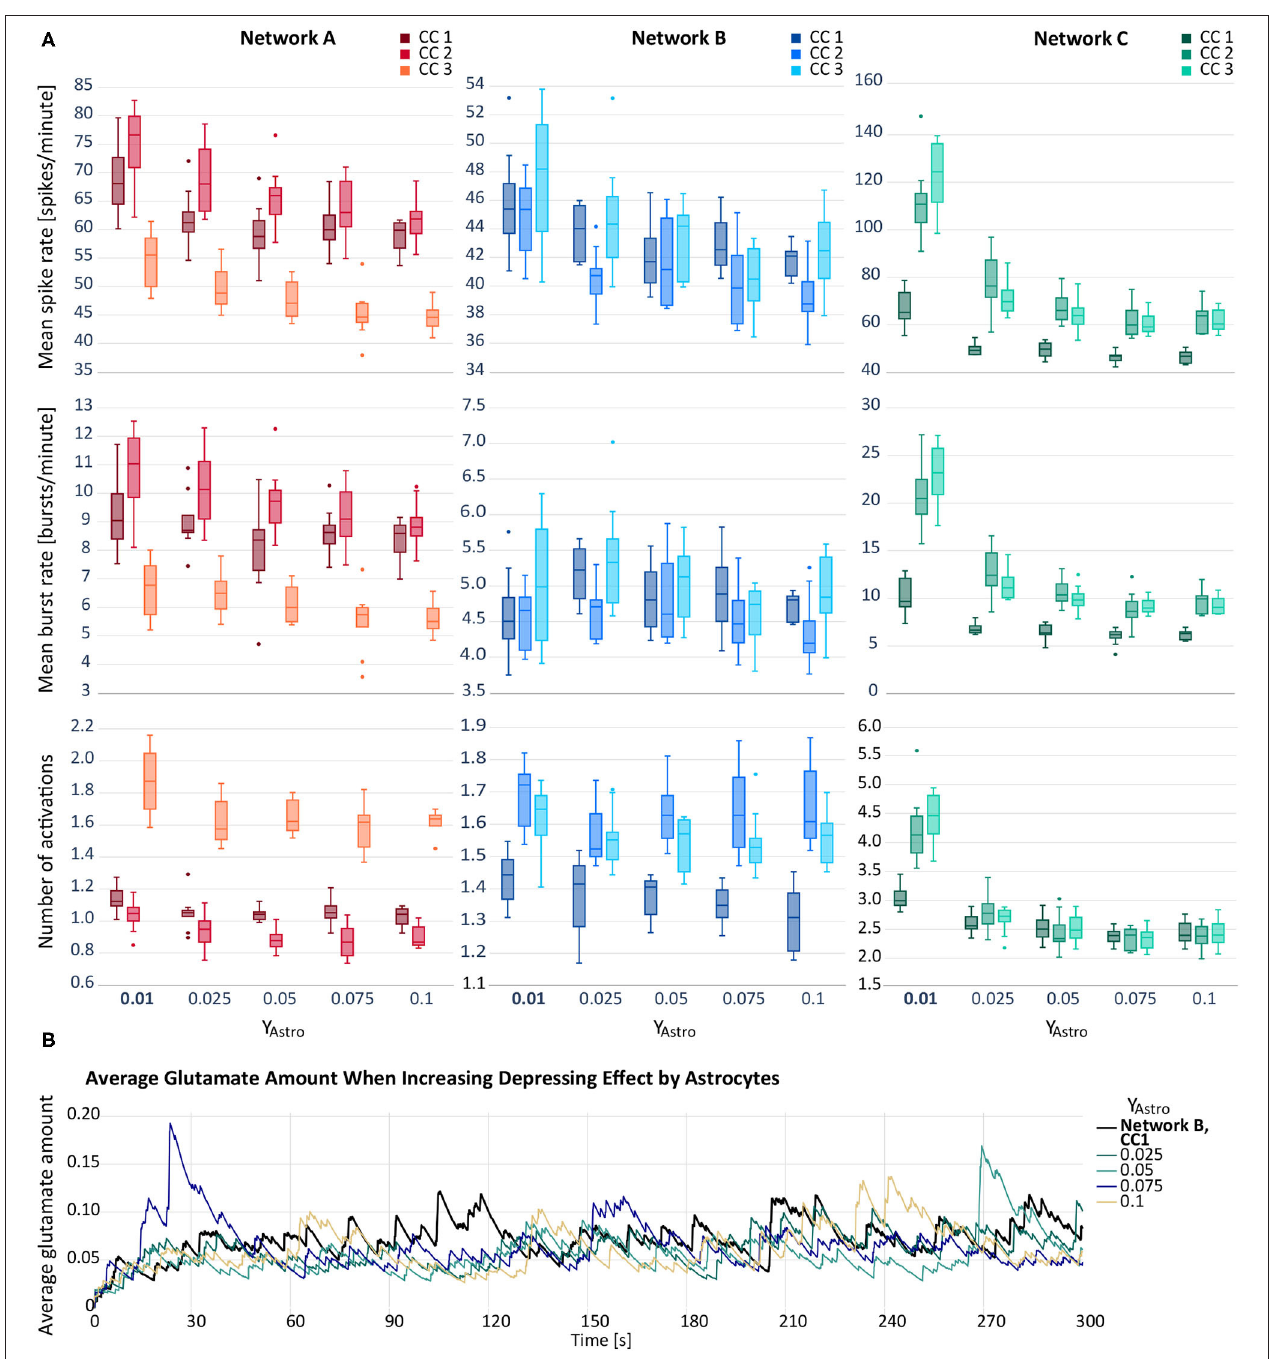
FIGURE 3 | (A) Mean spike rate (top), mean burst rate (middle) and mean number of activations per astrocyte (bottom) resulting from the networks with increased astrocytic depression compared to the default networks A–C with y Astro = 0.01 (bold). Note that the y -axes differ for each subfigure. (B) Average glutamate amount in astrocytes when applying a depressive effect on the postsynapse by releasing ATP from the astrocyte. The black line resembles the baseline activity from network B , CC 1 . The remaining lines represent deviating values of y Astro